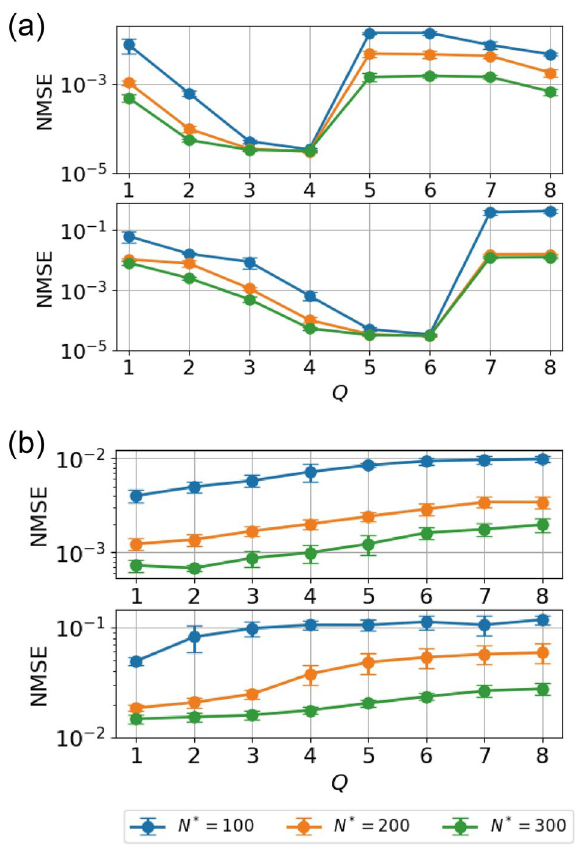
Figure 7. Q -dependence of the learning performance. ( a ) NMSE for a sixth-order Hénon-map task (the upper panel) and for an eighth-order Hénon-map task (the lower panel) for various values of Q with P = 1 . ( b ) NMSE for NARMA5 (the upper panel) task and for NARMA10 (the lower panel) task for various values of Q with P = 1 . Error bars show the standard deviation of the results of 10